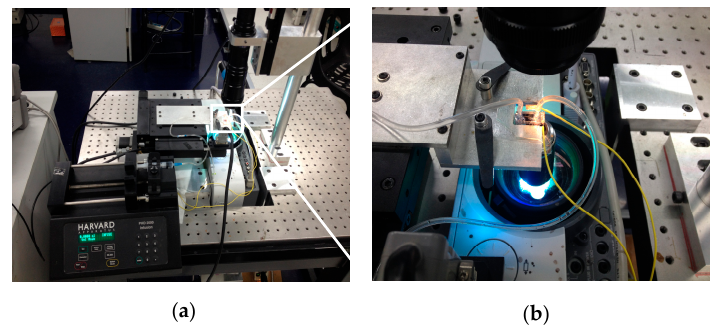
Figure 2. ( a ) Experimental setup of optically induced electrodeposition (OIED); ( b ) the OIED chip where electrochemical reactions occur.